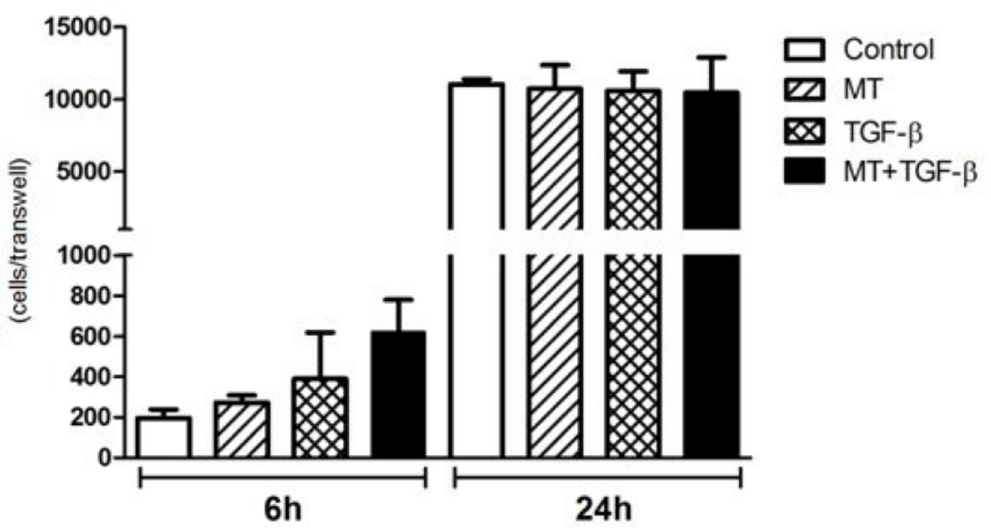
Fig 7. Analysis of the invasive potential of T24 cells by the Matrigel invasion assay. Although a greater level of invasive capacity was observed in T24 cells after 6 hours of TGF- β and MT + TGF- β treatment, no statistical significance was observed. After a migration period of 24 hours, no difference was found.